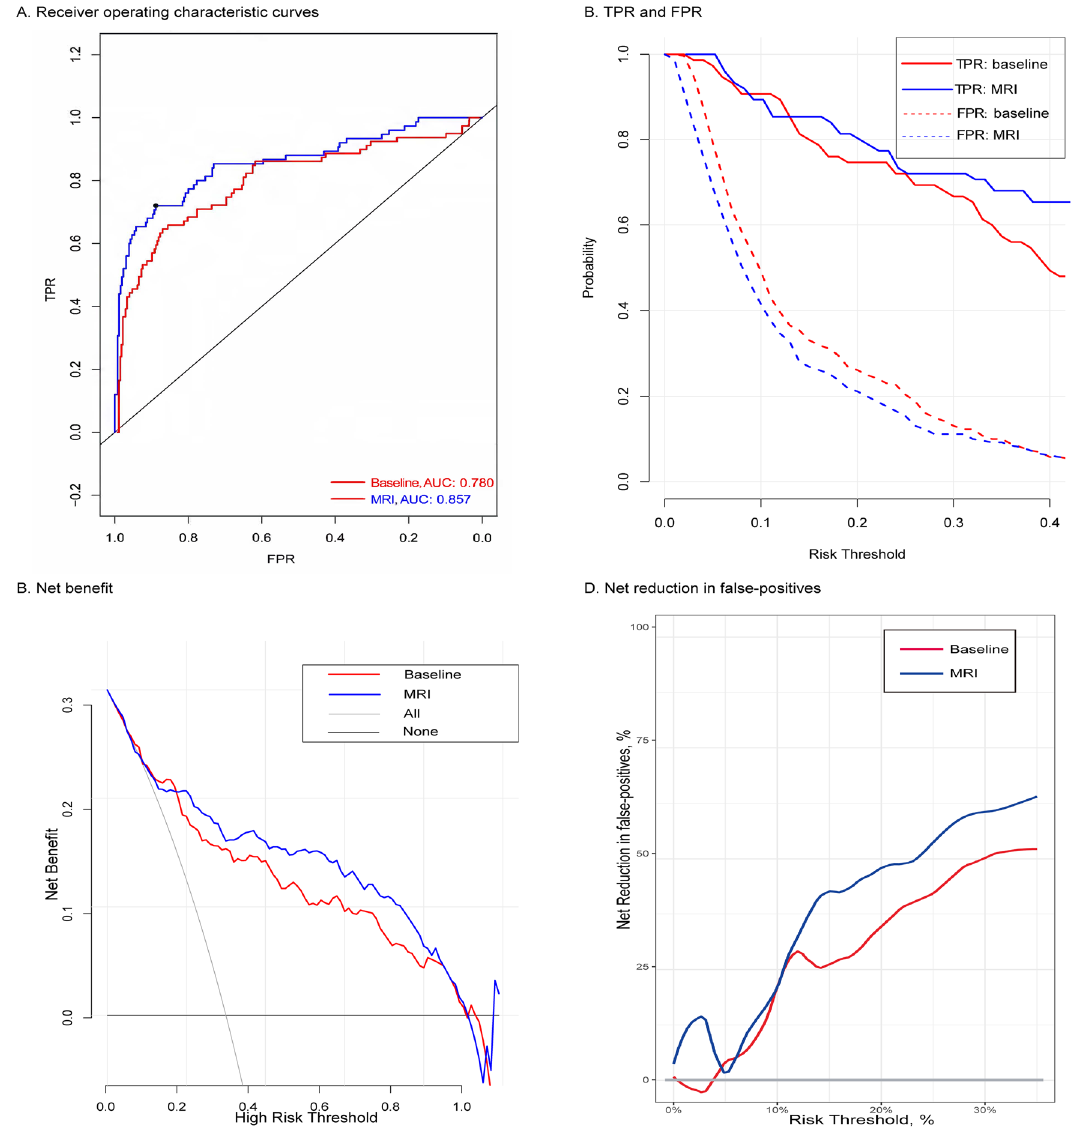
Figure 2. Plot showing the performance metrics of the research cohort. ( A ) Receiving operating characteristic curves or risk prediction models for CS prostate cancer, ( B ) TPR and FPR, ( C ) Net benefit (%), ( D ) Net reduction in false ‐ positives (%) of the three risk prediction